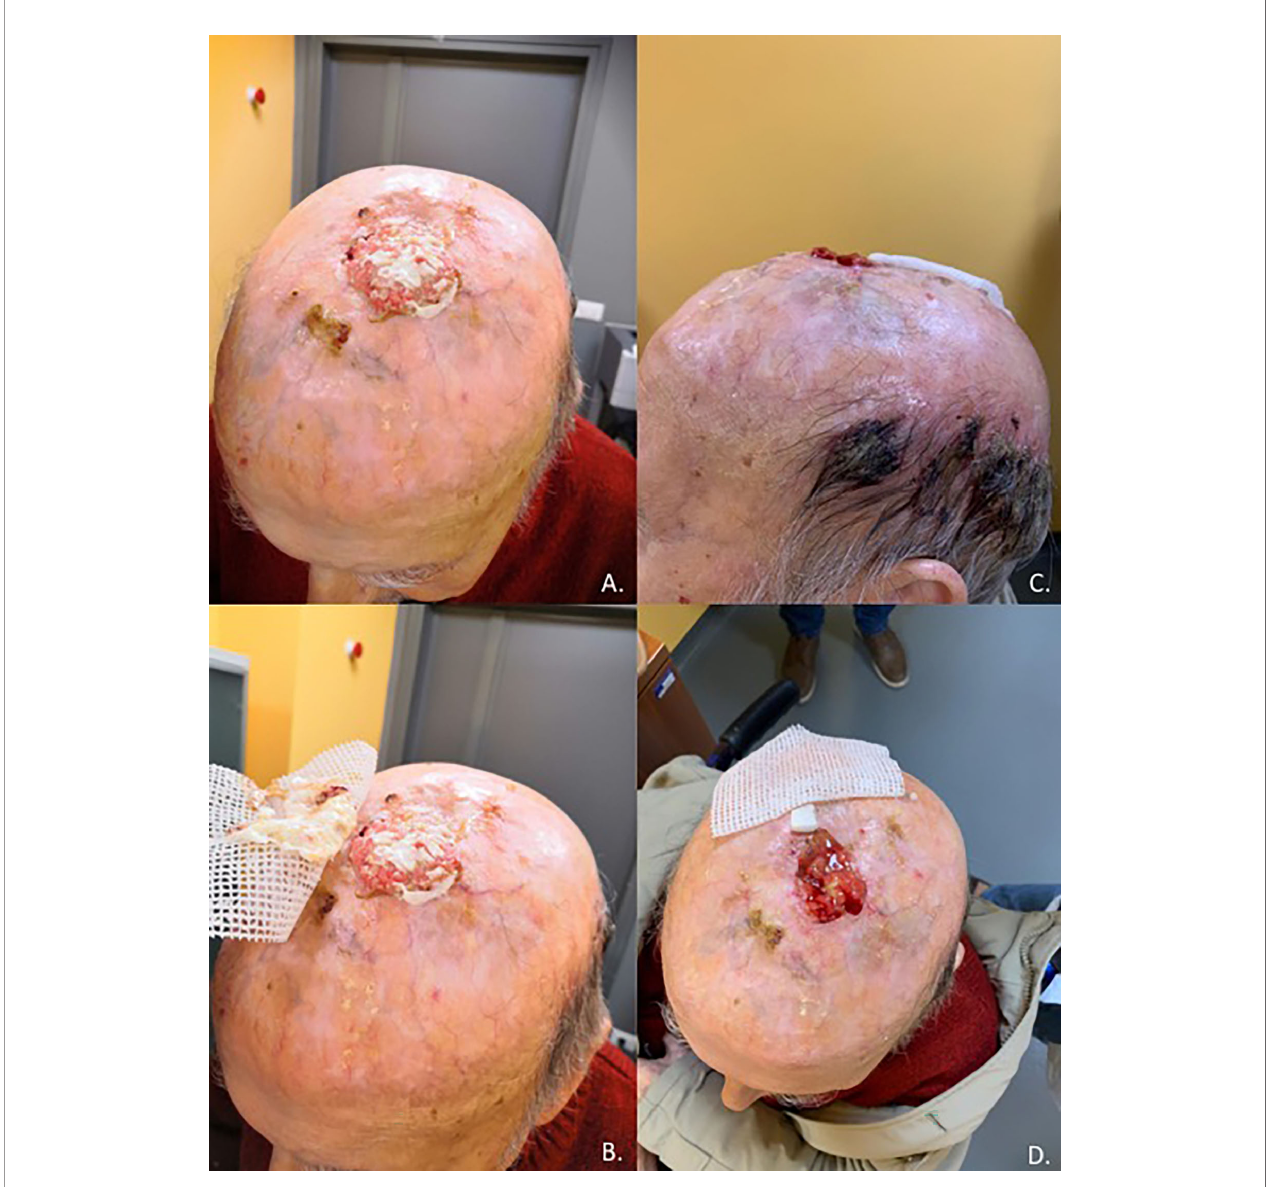
FIGURE 1 | Case report of a 92-year-old man with unresectable, non-eligible to curative radiotherapy, locally advanced CSCC invading the skullcap and leptomeningeal membrane (A, B) who achieved a rapid clinical response after one cycle of Cemiplimab (C, D)